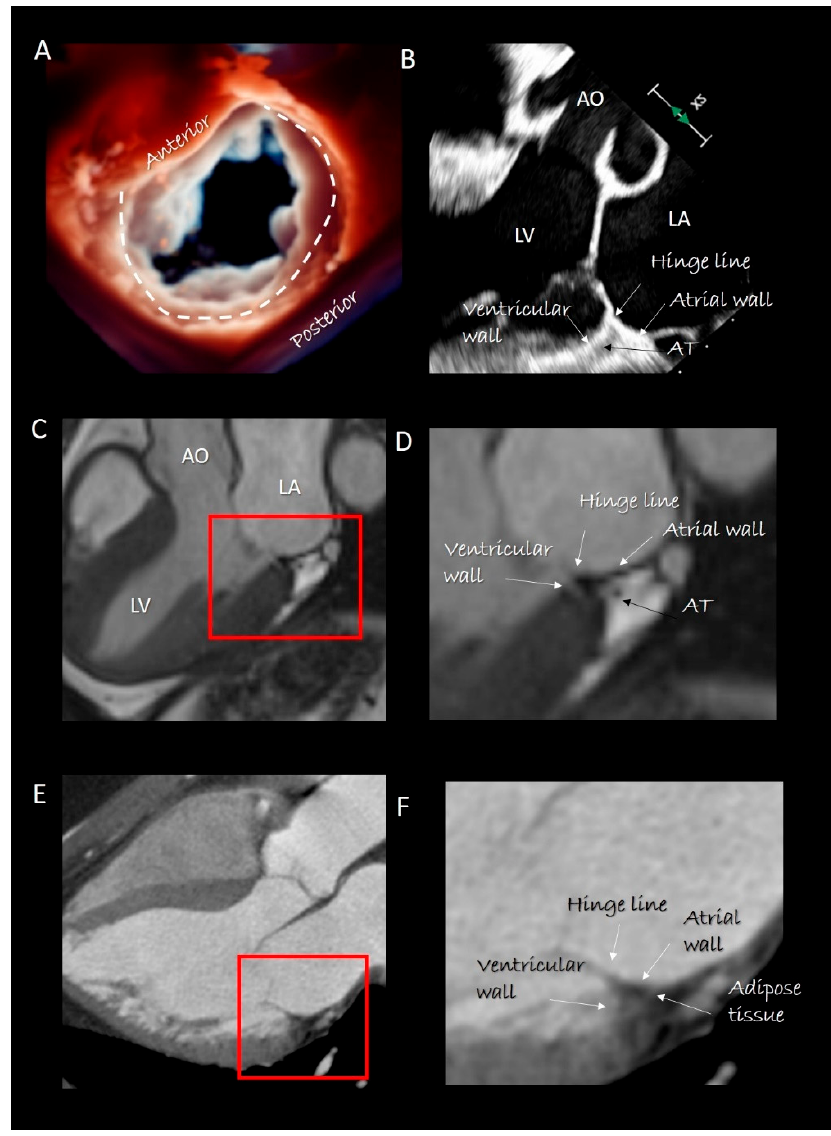
Figure 2. ( A ) 3D transesophageal echocardiography (TEE) still frame image of mitral valve forms an overhead perspective with a specific rendering algorithm that permits a movable source of light. With a source of light behind the valve, the two components of mitral annulus are well visible (the curved dotted line marks the posterior segment). ( B ) 2D TEE cross-section long-axis view showing the four components of posterior segment of annulus. The adipose tissue (AT) has a different texture compared with surrounding tissues. ( C ) CMR cross-section long-axis view. ( D ) Magnified image of the structures inside the red square in C showing the four components of posterior segment. The AT can be distinguished because the signal is much stronger (white in color) than that of surrounding structures. ( E ) Computed tomography (CT) cross-section long-axis view. ( F ) Magnified image of the structures inside the red square in E showing the four components of the posterior segment. As AT is more hypodense to x-ray, it appears as an area that is darker than the surrounding structures. AO = aorta; LV = left ventricle; LA = left atrium.